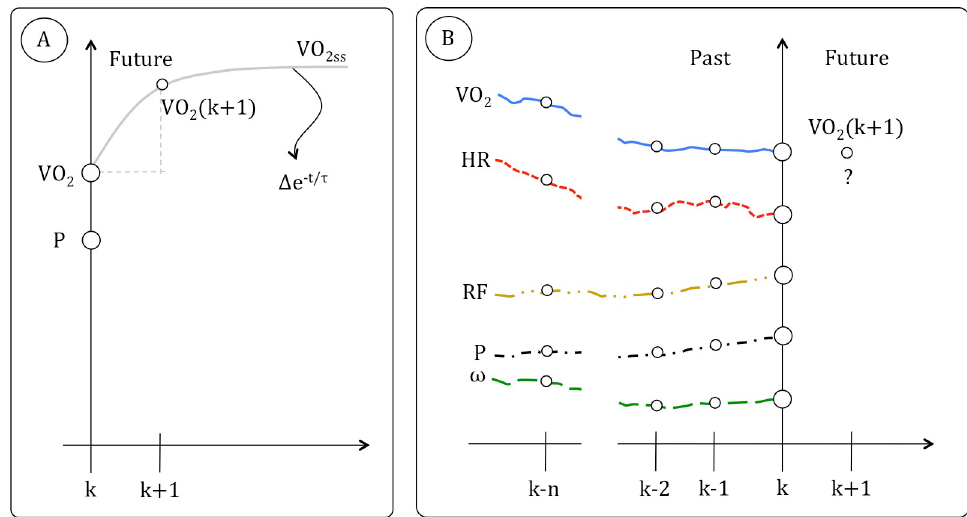
Fig 1. A schematization of the analytical equations approach (A) and artificial intelligence (AI) approach (B) is given. A: the current value of the power (P) and oxygen uptake ( _ VO (i.e. Δ e -t/ τ , with Δ calculated as the difference between the _ VO (i.e. _ VO ð k þ 1 Þ ). B: In an AI approach to the time-series problem, current (k) and past values (k-1, future values of _ VO 2 2 k-2, ... k-n) of heart rate (HR), P and cadence ( ω ) are used to forecast future values _ VO